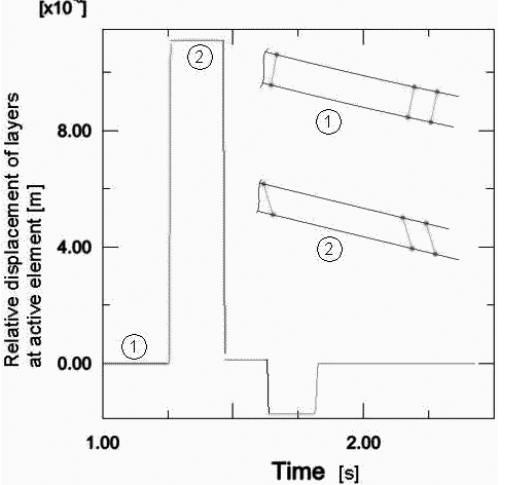
Fig. 12. Relative displacement of